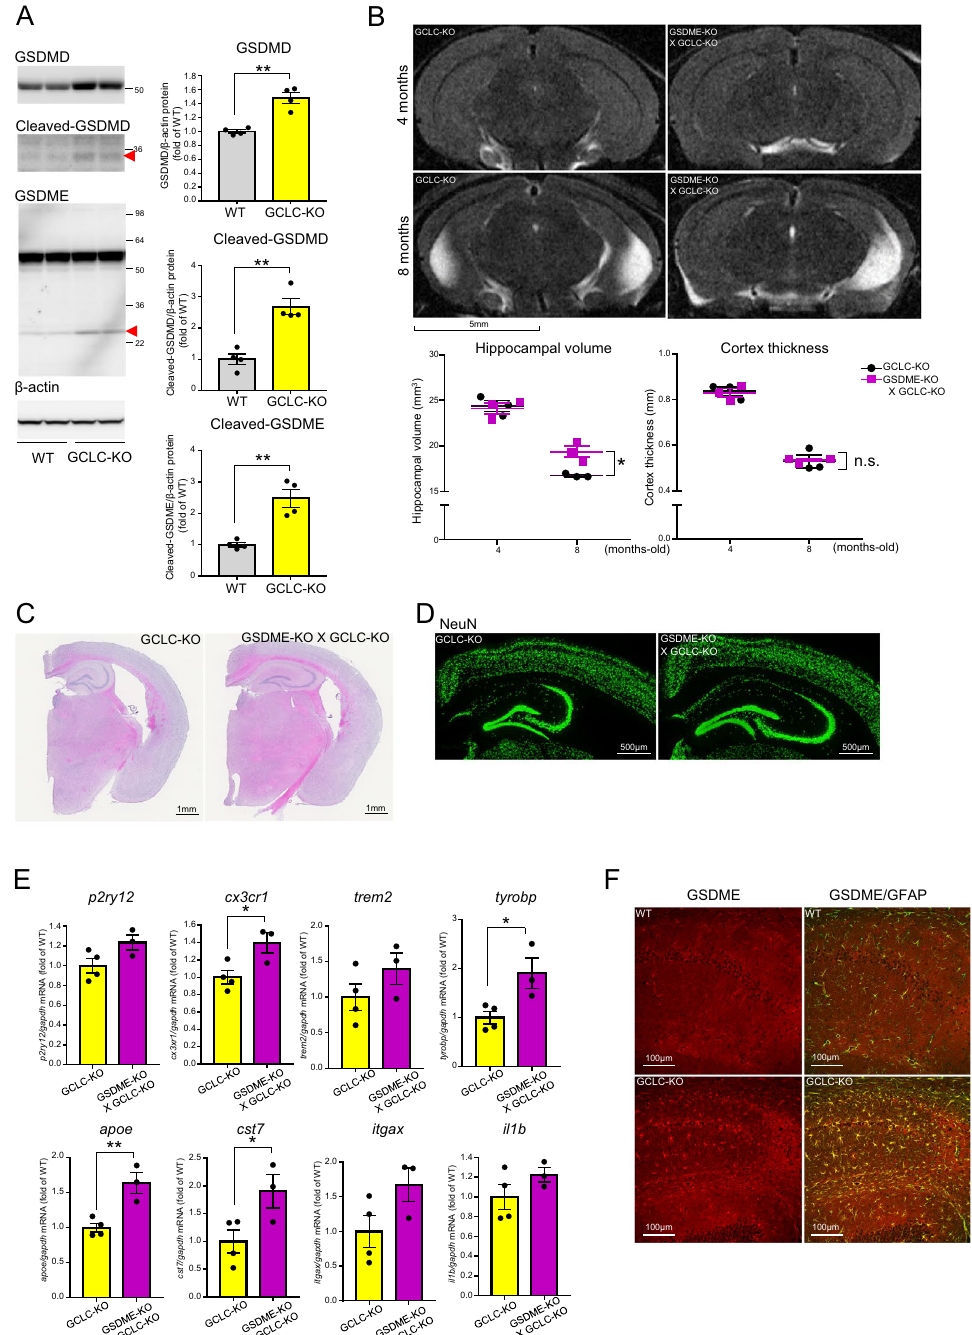
Figure 6. GSDME plays an important role in the neurodegeneration. ( A ) GSDMD and GSDME protein levels in 8-month-old WT and GCLC-KO mouse brains were determined by western blotting. Red arrowheads show cleaved form (active form) of GSDMD and GSDME, respectively. Values shown in the graph represent relative expression level of each protein (n = 3; ** p < 0.01). ( B ) Representative MRI scans of GSDME-KO X GCLC-KO and GCLC-KO mouse brains scanned at 4 and 8 months of age. Values shown in the graph represent the mean bilateral hippocampal volume (left) and cortical thickness (right) ± SEM. Differences between groups were analyzed by two-way ANOVA (n = 3; * p < 0.05). ( C ) Brain sections of 8-month-old GSDME-KO X GCLC-KO, GSDMD-KO X GCLC-KO and GCLC-KO were stained by H&E. ( D ) Brain sections of 8-month- old GSDME-KO X GCLC-KO and GCLC-KO were immunostained with NeuN antibody. ( E ) mRNA levels of microglia markers in GSDME-KO X GCLC-KO and GCLC-KO were determined. Values shown in the graph represent the mean relative expression level ± SEM (n = 3; * p < 0.05, ** p < 0.01). ( F ) Brain sections of 5-month-old WT and GCLC-KO were immunostained with GSDME and GFAP